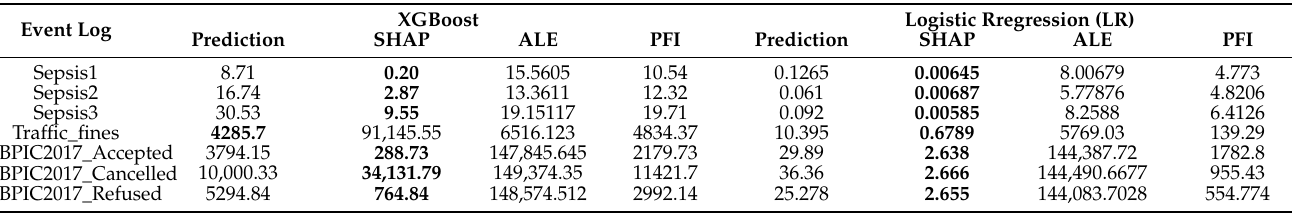
Table 3. Execution times (in seconds) of XAI methods on event logs preprocessed using single aggregation combination.